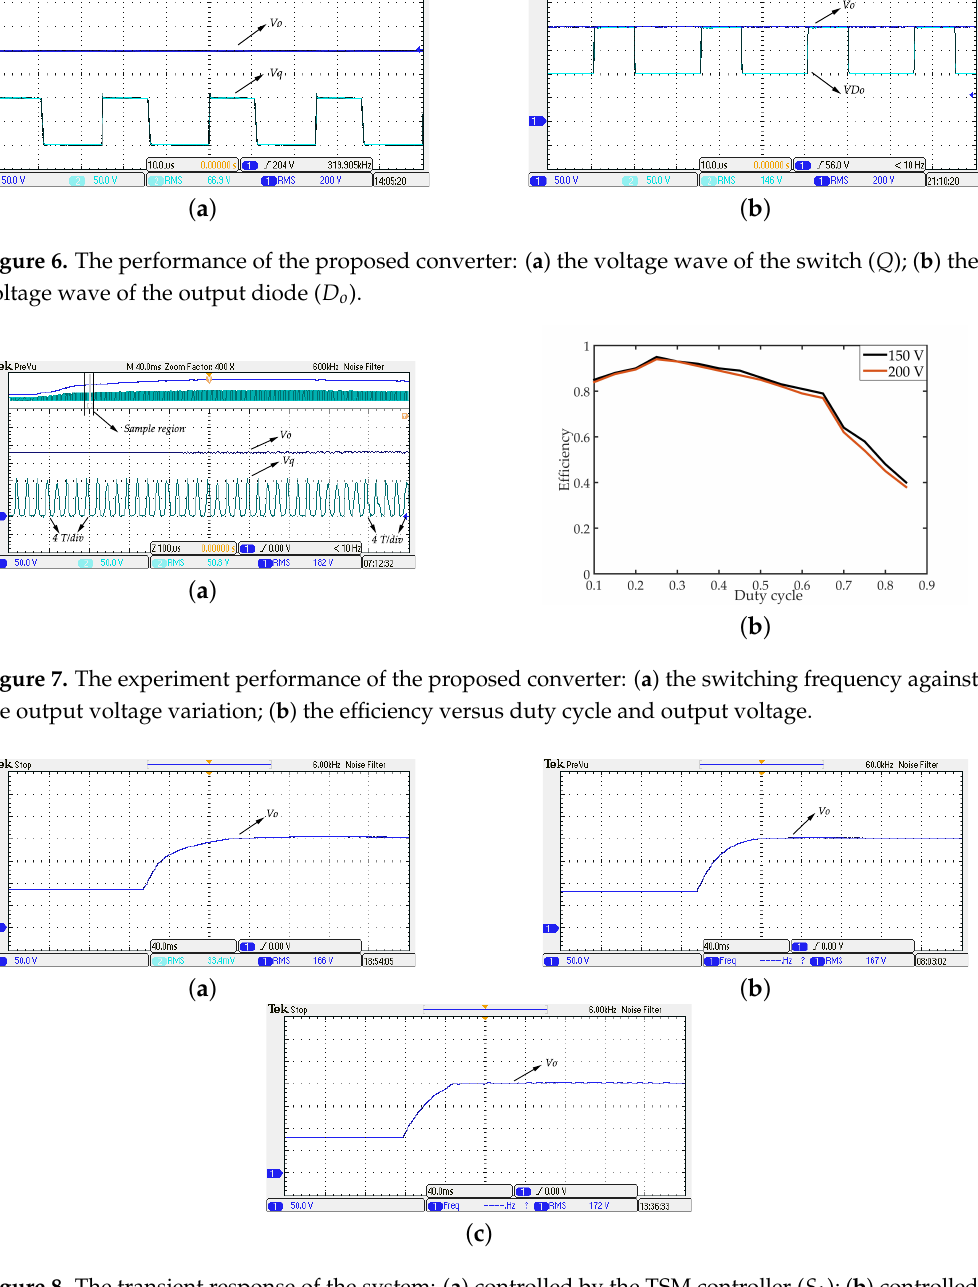
Figure 8. The transient response of the system: ( a ) controlled by the TSM controller ( S 1 ); ( b ) controlled by the FTSM controller ( S 2 ); ( c ) controlled by the proposed NFTSM controller ( S 3